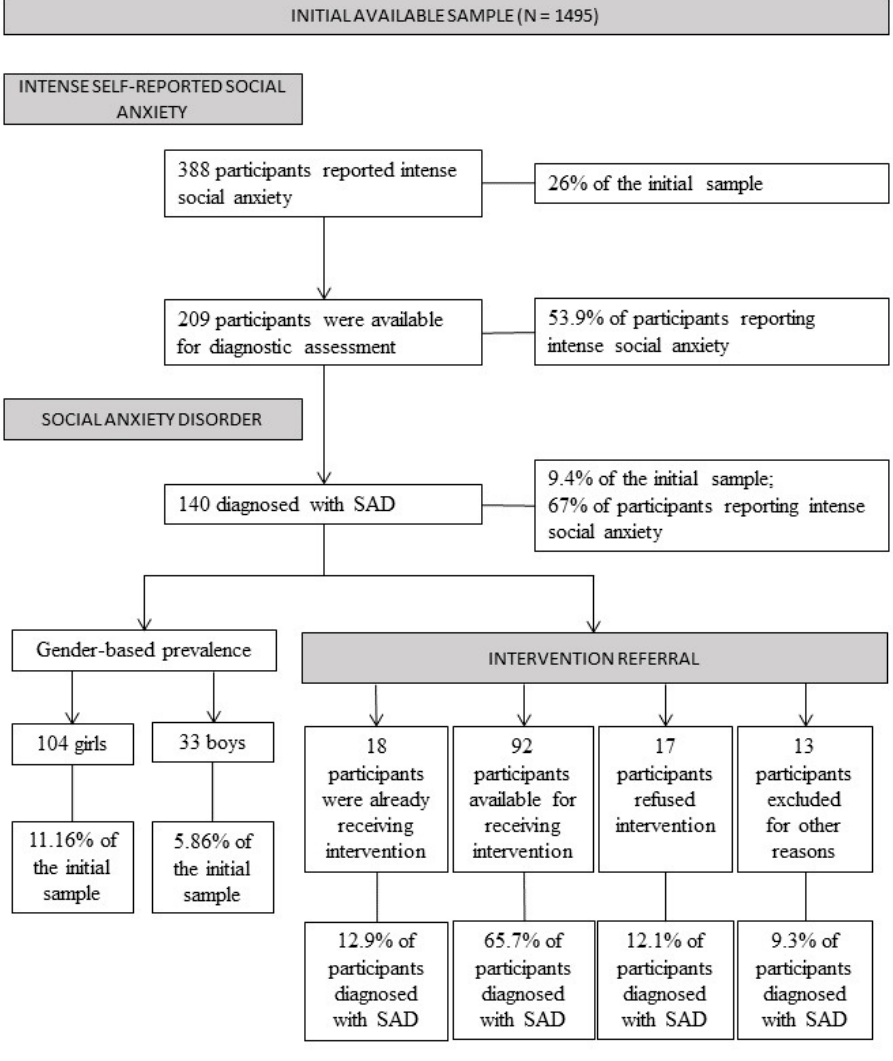
Figure 1. Flowchart of the prevalence estimates found for the screening, diagnostic assessment, and intervention referral phases of the current work.